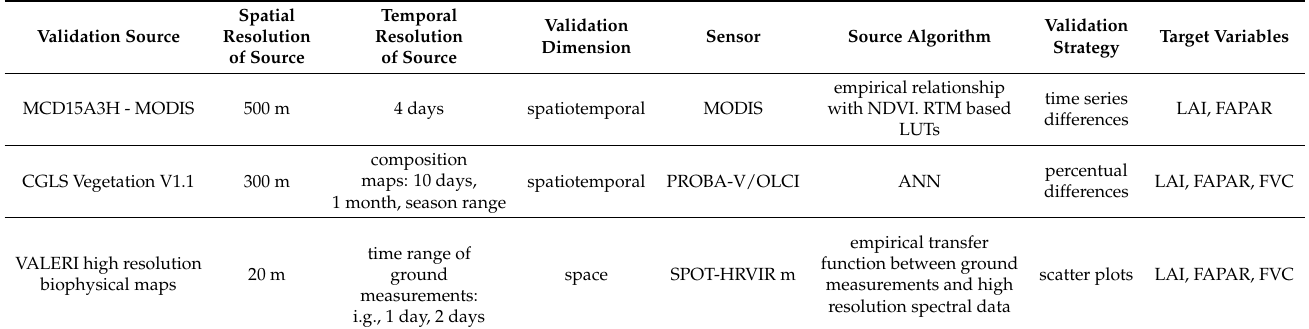
Table 3. Overview of the three data sets used for direct and indirect validation of vegetation traits models, including spatial and temporal resolutions, dimensions, sensors, source algorithms, strategy of presented validation and targeted variable. NDVI: Normalized Difference Vegetation